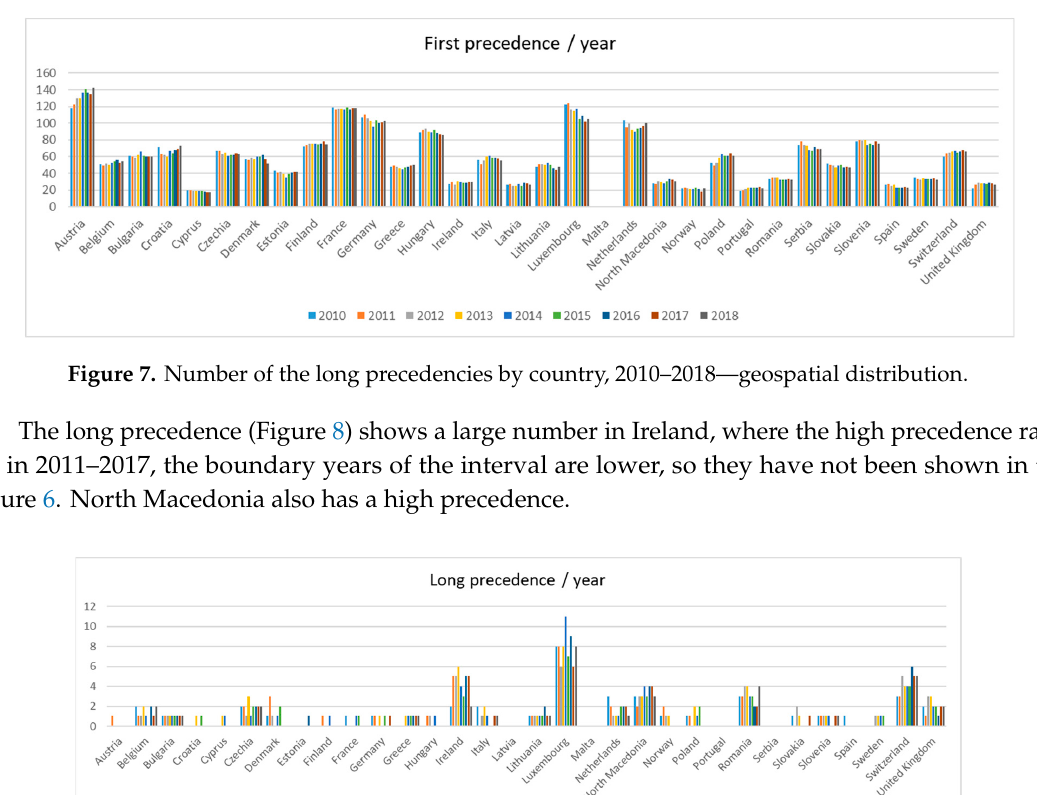
Figure 9. Number of first precedencies by country—geospatial distribution in 2010 and 2018.